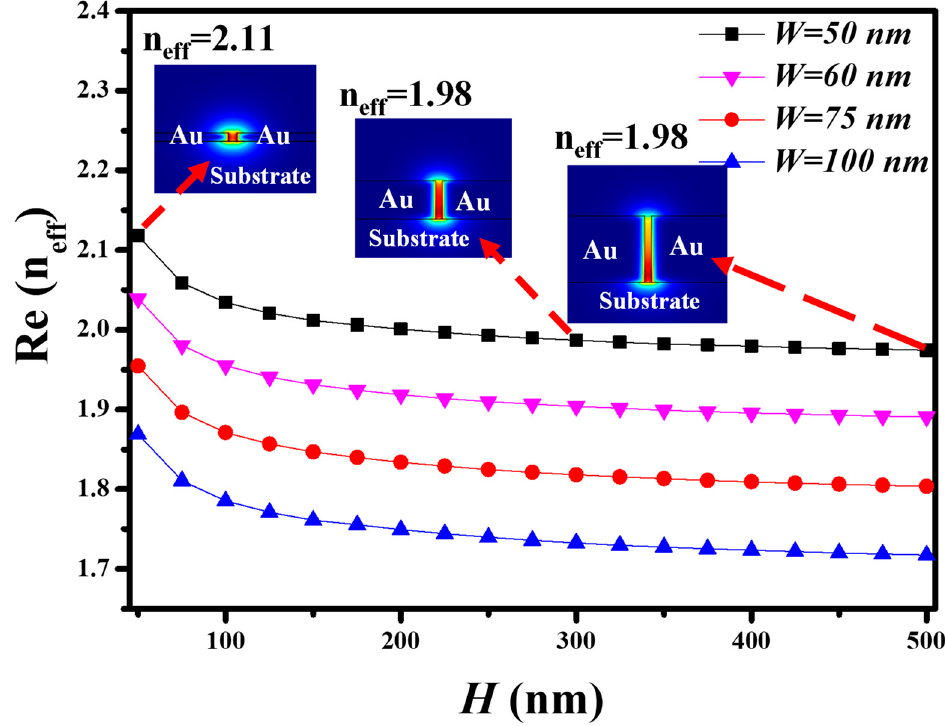
Figure 2. The real part of the effective refractive index versus the height ( H ) and slot width ( W ) of the MIM waveguide. Inset shows the cross-section E-field distribution in the MIM waveguide.